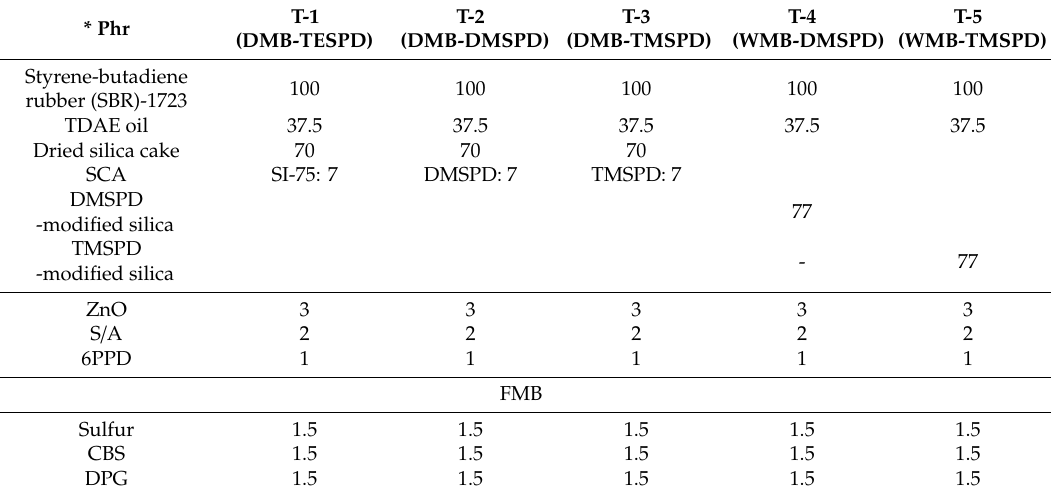
Table 1. The mixing compound